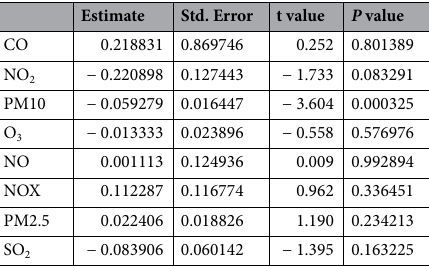
Table 2. Coefficients of the GLM model fitted to the rainy season rainfall quantity data (2000–2021).